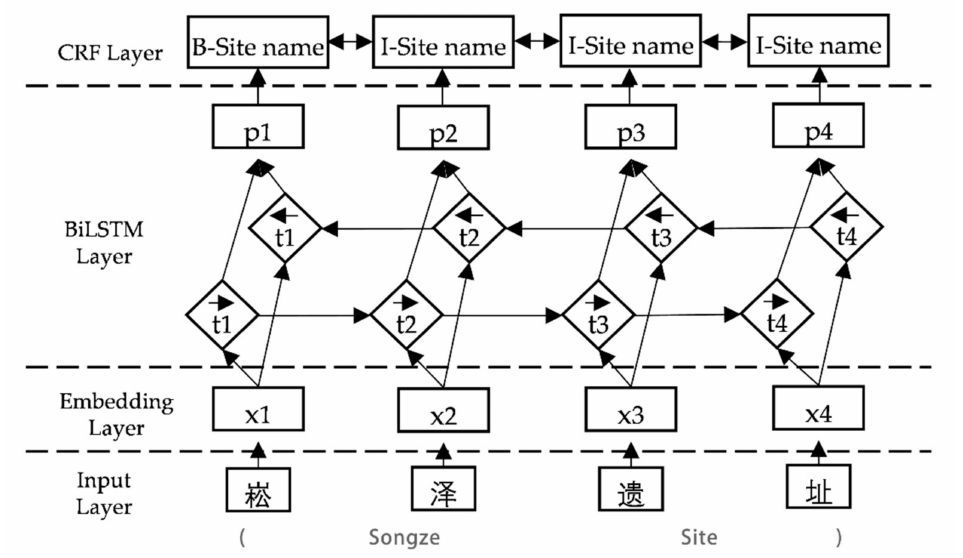
Figure 3. Bidirectional Long Short-Term Memory with Conditional Random Fields (BiLSTM- CRF)